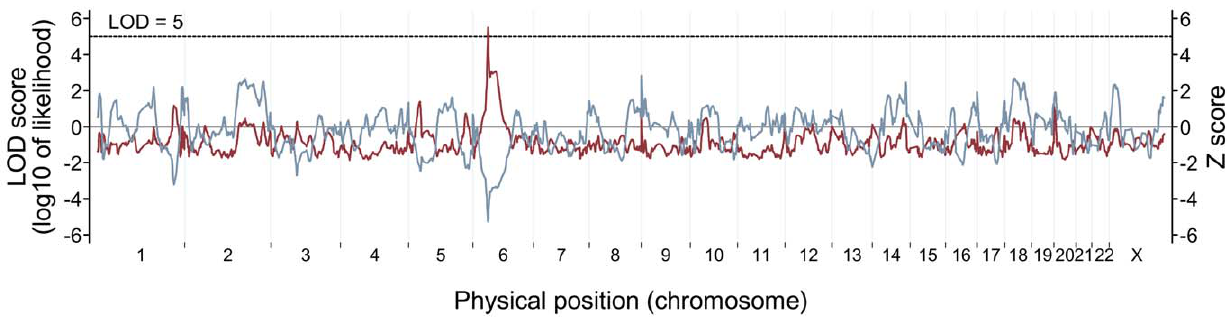
Figure 2. Genome-wide admixture mapping scans for loci affecting retinal venular caliber in hypertensive individuals. For case-only analysis (LOD score, red line), the genome-wide score was 2.31, reaching the threshold of . 2 for significance. The highest locus-specific LOD of 5.47 was detected at 6p21.1, and this score again met the threshold of . 5 for significance. The admixture-generated signal was further supported by case- control analysis (Z score, blue gray line). At the 6p21.1 peak, the cases had highly significantly lower percentage of European ancestry than the